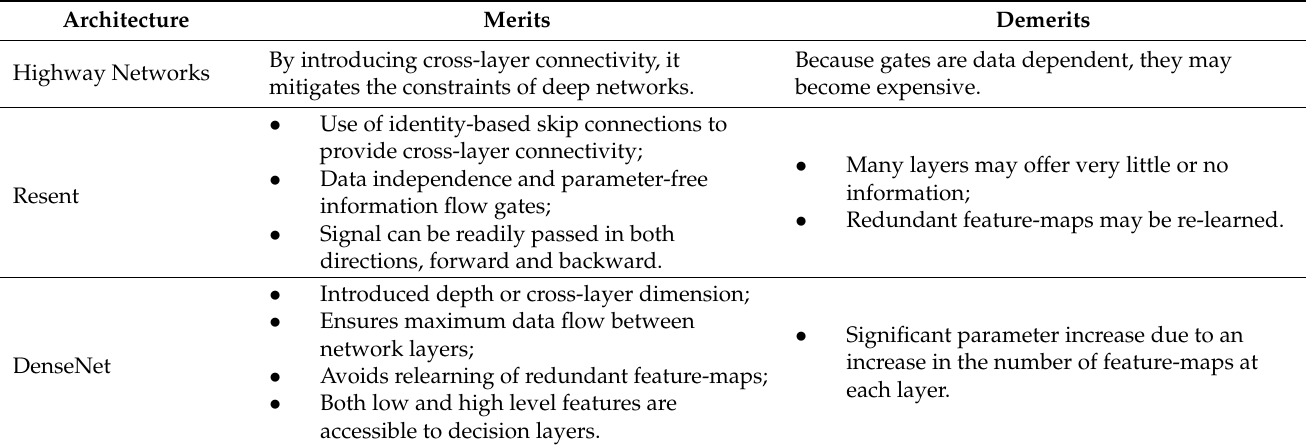
Table 4. Major issues linked with the deployment of multi-path-based CNN architectures. Architecture Merits Demerits By introducing cross-layer connectivity, it Highway Networks mitigates the constraints of deep networks.